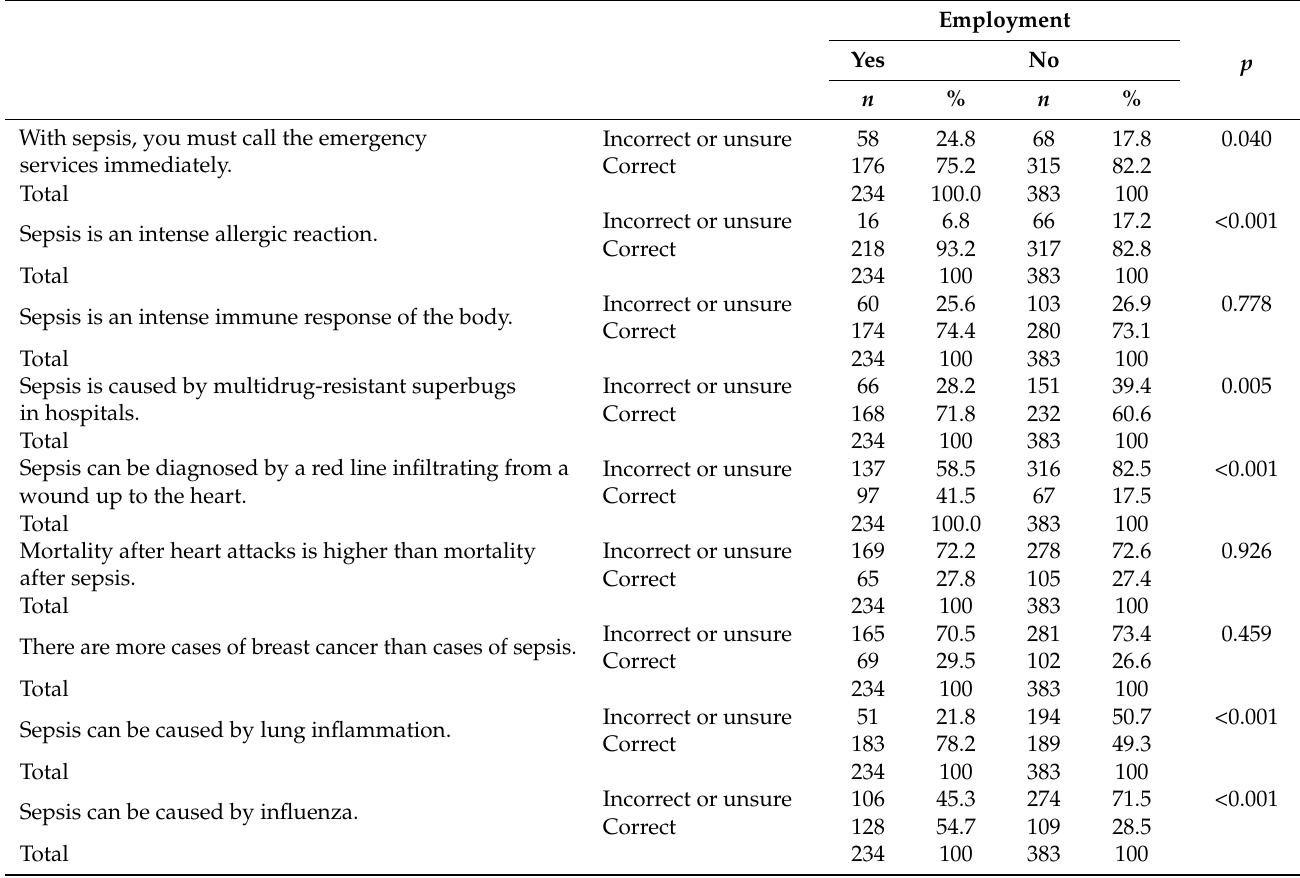
Table 3. Percentage and number of students with correct answers to “Knowledge of sepsis” according to employment.